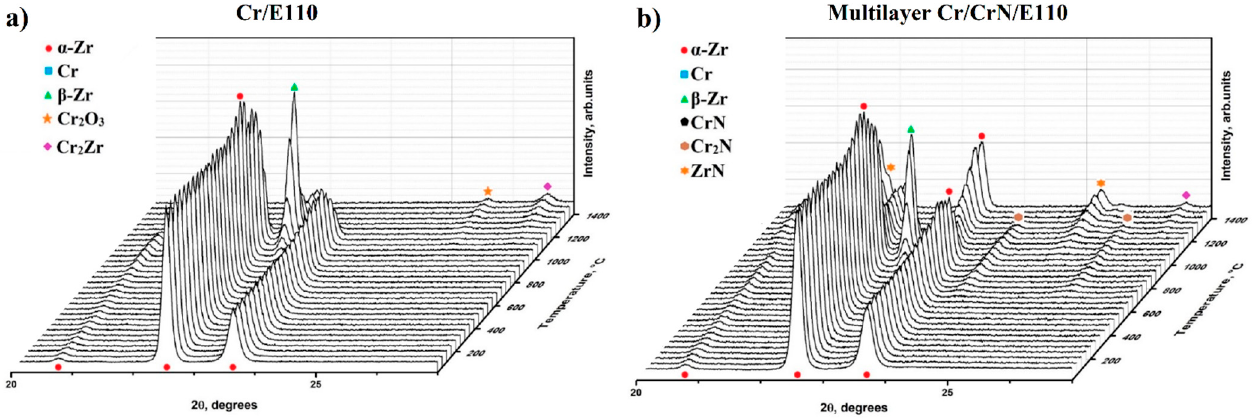
Figure 16. In situ XRD patterns of an E110 alloy with single-layer Cr ( a ) and multilayer Cr/CrN ( b ) (layer step-250 nm) coatings under linear heating in the temperature range of 25–1400 °C. Replotted from [195].